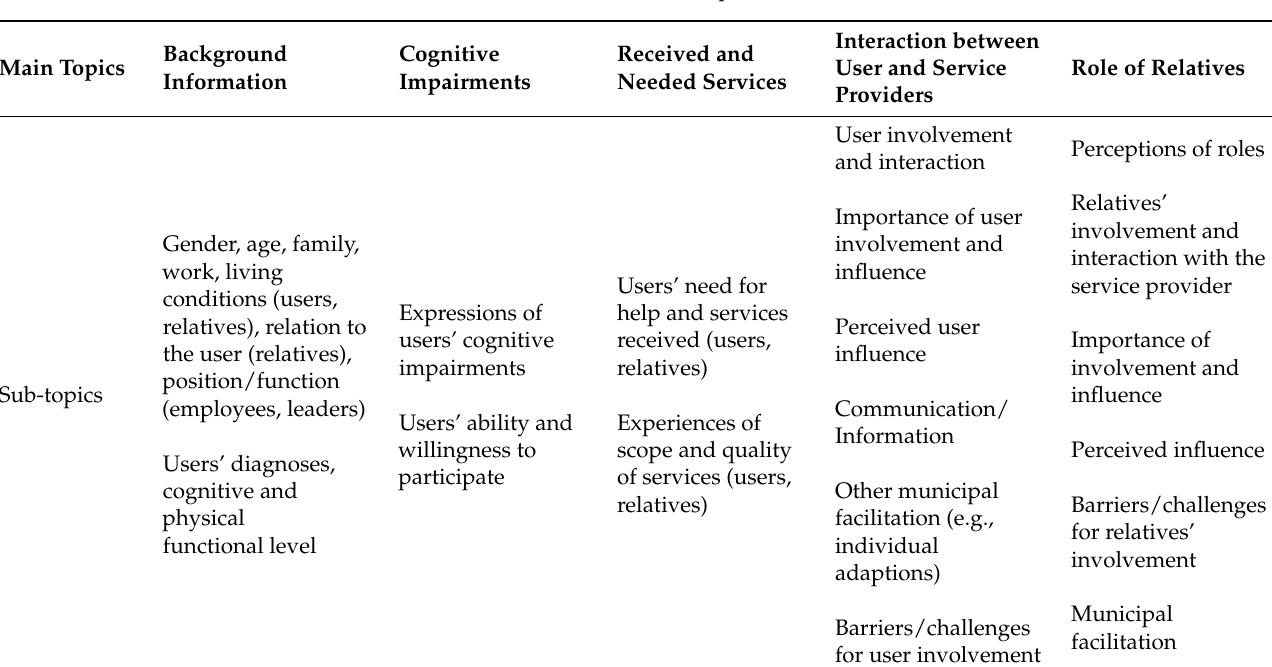
Table 3. Interview